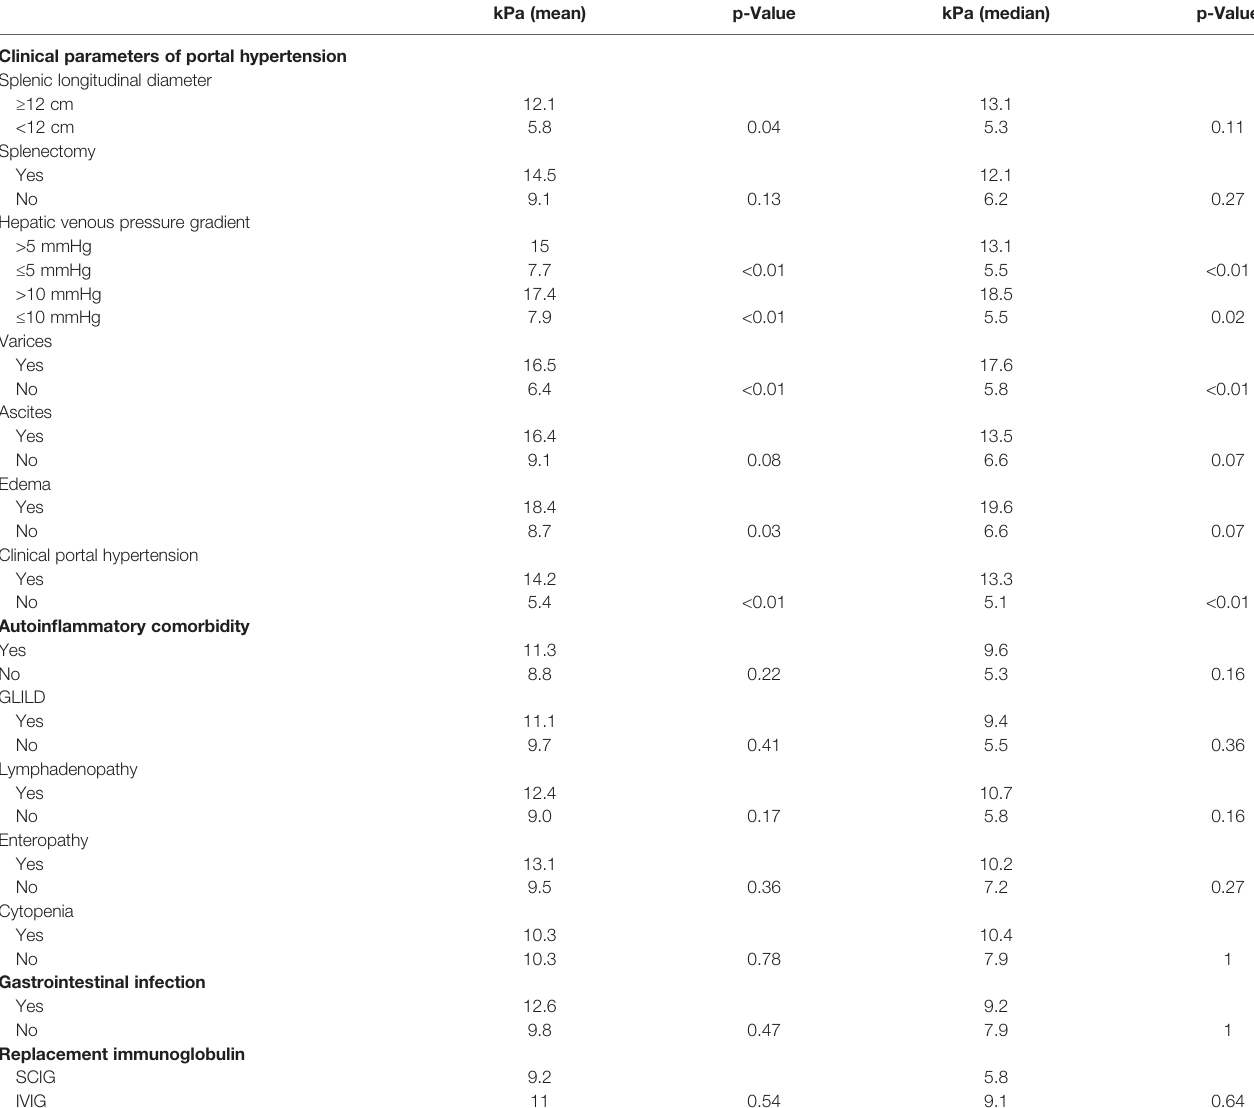
TABLE 1 | Liver stiffness by transient elastography correlates with clinical markers of portal